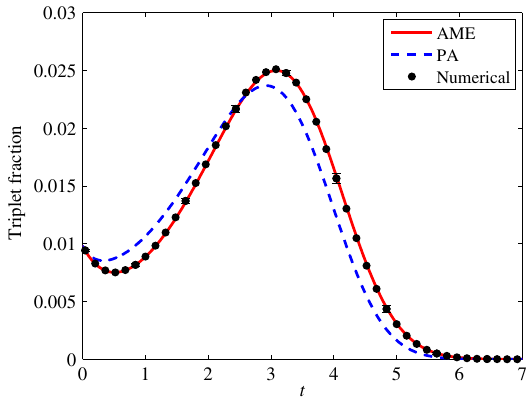
FIG. 3. Bass diffusion dynamics on a four-regular random graph (or Bethe lattice, P d ¼ (cid:1) 1 = 4 and initial condition (cid:5) ð 0 Þ ¼ 10 (cid:1) 2 . The AME and PA solutions for the fraction of adopted nodes are both given by the explicit formula (12).